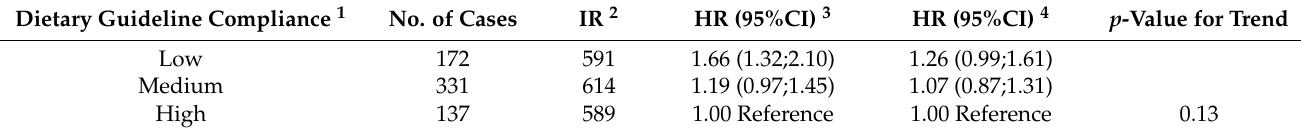
Table 6. Association between dietary guideline compliance and risk of all-cause mortality, n = 9848. Dietary Guideline Compliance